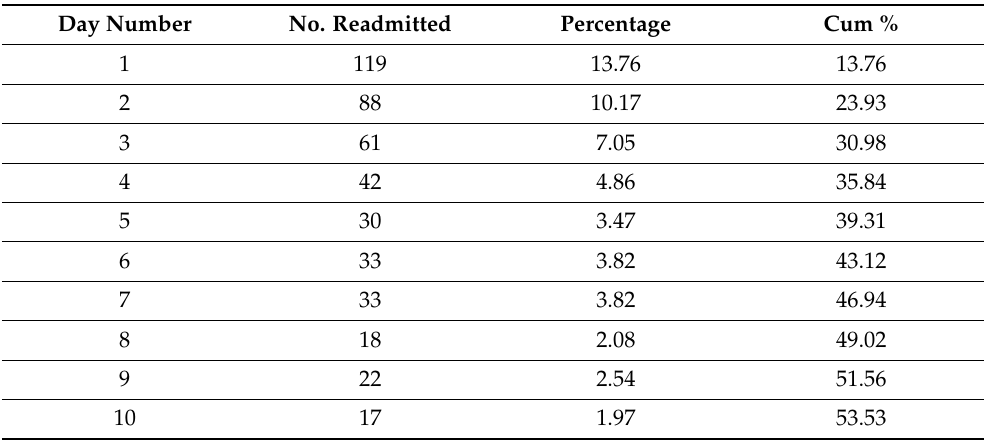
Table A2. Distribution of the readmittance of the 865 dogs adopted from RSPCA Queensland in 2019 and 2020 by the day of the adoption period when they were readmitted following their initial adoption (day of adoption = day 1, the next day = day 2 and so on). The median time to when dogs were readmitted was the 9th day of the adoption